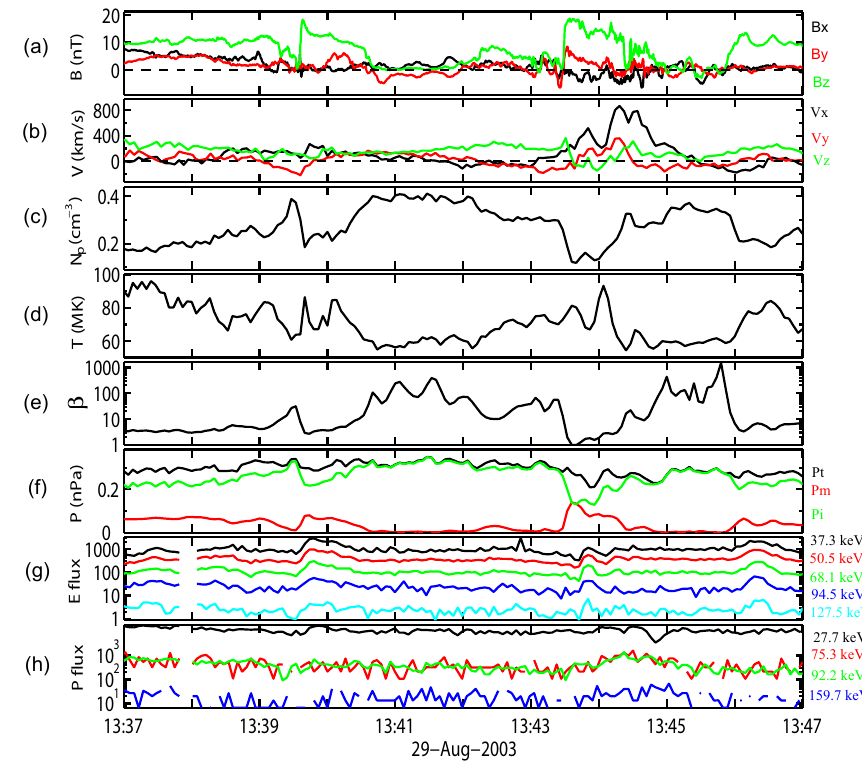
Fig. 2. Overview of magnetic field, ion plasma data, and electron plasma data observed by Cluster-4 between 13:37UT to 13:47UT on 29 August 2003. The top panel shows the three components of magnetic field. The next three panels show the three components of ion plasma velocity, ion plasma density and temperature, respectively. The fifth panel shows the ion plasma β and the sixth panel shows the thermal pressure, magnetic pressure and total pressure. The last two panels show electron differential fluxes (1/(cm 2 strskeV)) and proton differential fluxes (1/(cm 2 strskeV)) measured by the RAPID